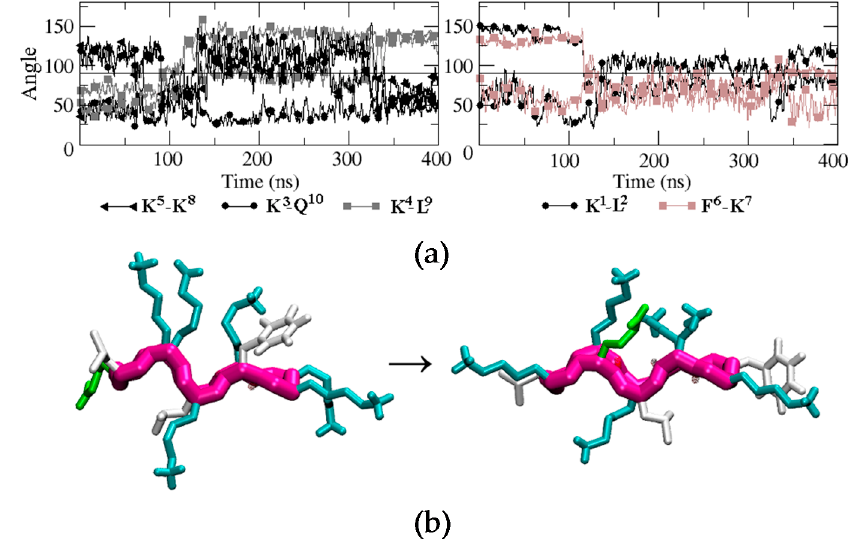
Figure 5. ( a ) Time evolution of the angle formed between the normal vector to the backbone plane and the vector representing each of the side chains. Black, brown, and grey curves correspond to hydrophilic, hydrophobic, and hydrophobic-hydrophilic pair residues, respectively. ( b ) Snapshots of BPC198 at 0 ns (left) and at 350 ns (right).